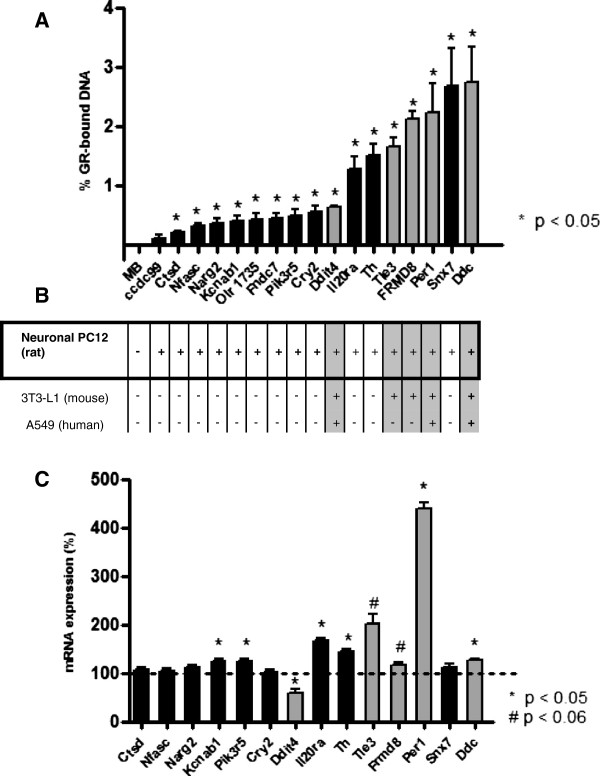
Validation of GR binding sites and effects on mRNA expression. A ChIP-PCR validation of identified GBS, previously shown to be GR-targets in literature (grey bars) or representing newly identified GBS (black bars). The genes that are associated with the GBS are listed on the x-axis. The y-axis represents the % of input DNA that was bound by the GR after subtracting the aspecific IgG-bound fraction and the amount of GR bound after vehicle (VEH) treatment. The error bars represent the standard error of the mean (SEM) when comparing the DEX-induced GBS versus the VEH-induced GBS. An unpaired two-tailed T-test was used for statistics. B Diagram indicating whether the known GR-binding regions were previously detected in other published GR-ChIPseq studies based on BlastZ-based interspecies conservation (http://main.g2.bx.psu.edu/) [37]. The genomic locations corresponding to the GBS are listed in Additional file 3: Table S3 as region numbers 1 (Ddc), 7 (FRMD8), 8 (Per1), 11 (Snx7), 14 (Il20ra), 17 (Th), 75 (TLE3), 94 (Ddit4), 345 (Olr1735), 352 (Fndc7), 366 (Pik3r5), 526 (Cry2), 704 (Nfasc), 842 (Narg2), 976 (Kcnab1), 1020 (Ctsd). C mRNA expression of the genes associated with the validated GBS after DEX-treatment relative to VEH-treatment (100%). Expression was normalized against tubulin 2a mRNA expression. The non-parametric Wilcoxon Signed Ranks Test was used for statistics.